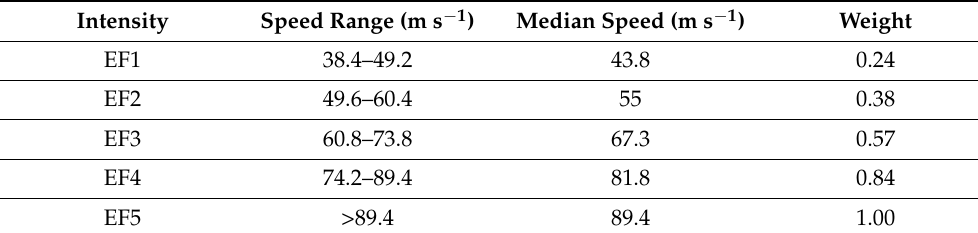
Table 1. Tornado intensity-based